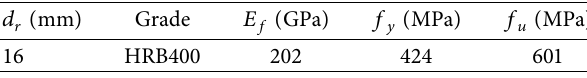
Table 2: Mechanical properties of the